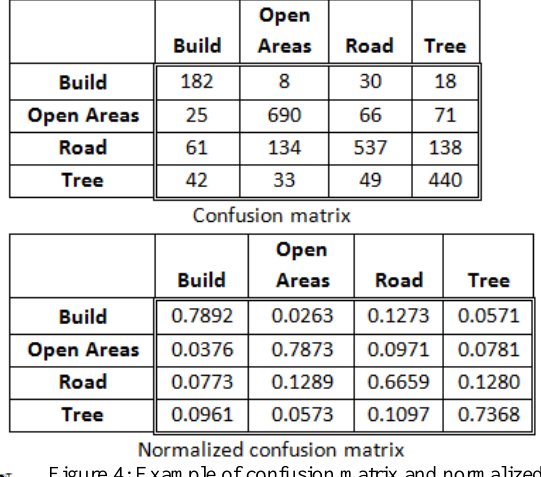
Figure 4: Example of confusion matrix and normalized confusion matrix for one of the data-layers